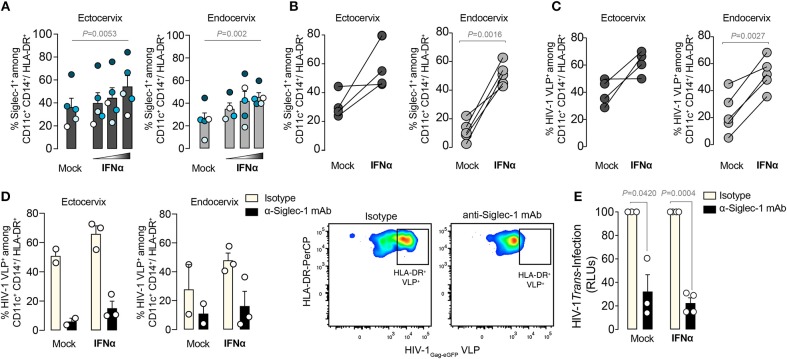
IFNα enhances viral capture and trans-infection on Siglec-1+ cervical DCs. (A) Percentage of Siglec-1+ DCs within the myeloid HLA-DR+ CD14+ CD11c+ fraction from small pieces of ectocervix or endocervix cultured in the presence or absence of increasing concentrations of IFNα (1,000; 10,000; and 100,000 IU/ml) and assessed by FACS as in Figure 3. Bar graph shows mean values and SEM from 5 donors and 4 independent experiments. Colors depict each particular donor. Statistical differences were assessed with a one-way repeated measures ANOVA test. (B) Percentage of Siglec-1+ DCs within the myeloid HLA-DR+ CD14+ CD11c+ fraction from cellular suspensions obtained from tissue digestion and cultured in the presence or absence of IFNα. Statistical differences were assessed with a paired t-test. (C) Percentage of cells capturing HIV-1Gag−eGFP VLPs among the myeloid HLA-DR+ CD14+ CD11c+ fraction from cellular suspensions obtained from ectocervix or endocervix digestion and cultured in the presence or absence of IFNα. Statistical differences were assessed with a paired t-test. (D) Percentage of cells capturing HIV-1Gag−eGFP VLPs as in (C) on cells that had been previously pre-incubated with 20 μg/ml of 7D2 anti-Siglec-1 mAb or isotype control. Bar graph shows mean values and SEM from 2-3 donors. Dot plots showing representative inhibition are also depicted. (E) Relative R5 tropic HIV-1NFN−SX transmission to CD4+ target cells from cervical CD45+CD3−CD19− HLA-DR+ sorted cells pre-incubated with 20 μg/ml of isotype or anti-Siglec-1 mAbs before viral exposure. Values are normalized to isotype-treated cells (set at 100%). Statistical differences were assessed with a one sample t-test. Mean values and SEM from two experiments include cells from 3 or 4 donors.